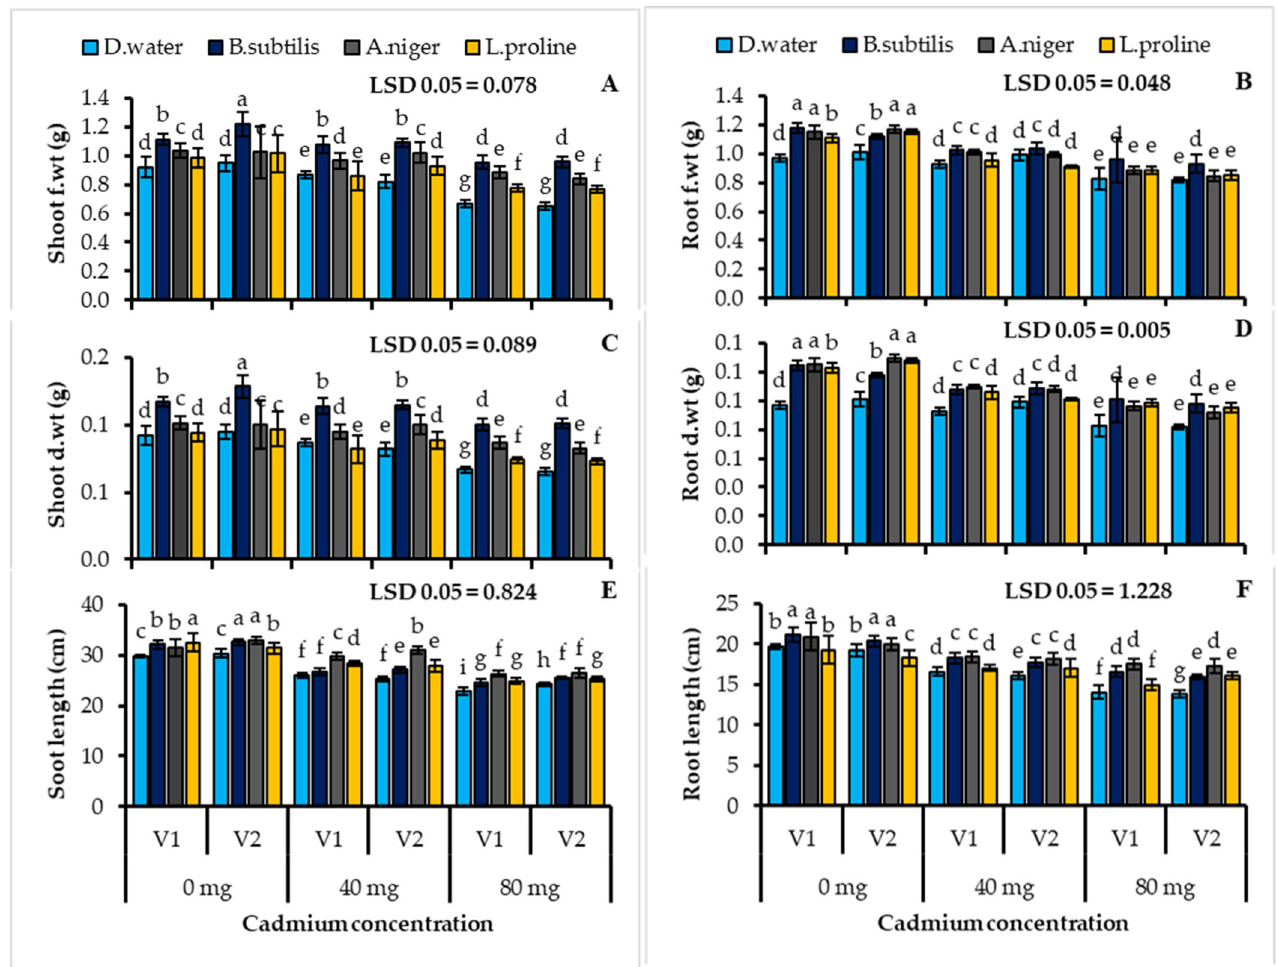
Figure 1. Shoot fresh weight ( A ) root fresh weight ( B ) shoot dry weight ( C ) root dry weight ( D ) shoot length ( E ) root length ( F ) of two cultivars of wheat ( Triticum aestivum L.) treated with Bacillus subtilis , Aspergillus niger and L ‐ proline subjected to the cadmium stress condition (Mean ± S.E.). Here V1 = AKBAR and V2 = DILKASH. The lower ‐ case letters represent the significant difference in data. The plant growth decreased significantly under the cadmium stress (40, 80 mg/kg soil), the reductions in the plant shoot length of V1: AKBAR (23.38%), V2: DILKASH (20.29%) and the root length V1 (28.60%), V2 (28.08%) in untreated plants were noticed (Table 3, Figure 1). In both wheat ( Triticum aestivum L.) cultivars, the shoot and root lengths were improved by the bacterial, fungal, and chemical treatments under cadmium stress. The inoculation with Bacillus subtilis (V1: 7.45, V2: 5.36%), Aspergillus niger (15.33, 9.35%), and L-proline (8.91, 4.13%), compared to the untreated stressed control, the stressed plants of both wheat cultivars had longer shoots (Table 3, Figure 1E). The treatment with Bacillus significantly lengthened the plant roots as Bacillus subtilis (V1: 17.77, V2: 15.42%), Aspergillus niger (24.64, 25.06%) and L-proline (6.40, 16.14%) compared to the untreated stressed plants in both cultivars (Table 3, Figure